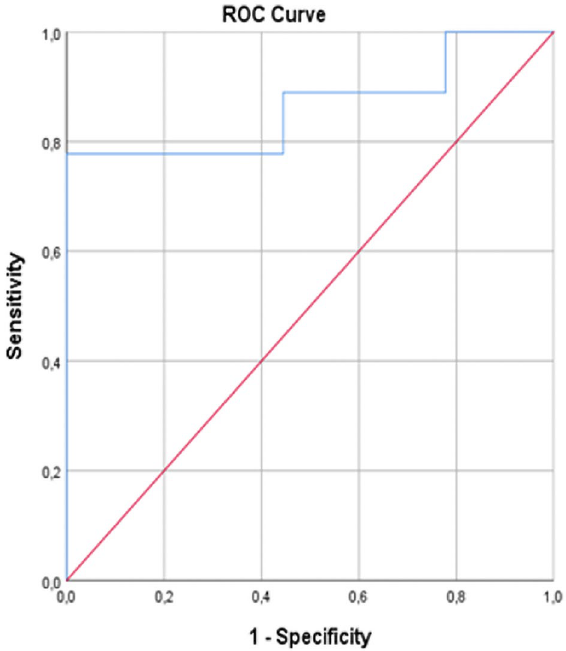
Figure 6. ROC curve of cRBF measured by ASL-MRI for distinguishing allografts with impaired function from allografts with good